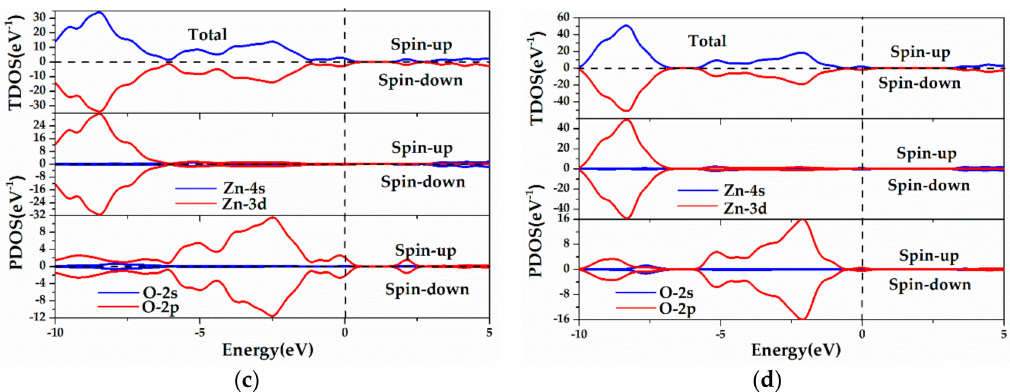
Figure 5. The calculated TDOS and PDOS (total and partial density of states) of ( a ) ZnO ML, ( b ) Y-ZnO, ( c ) V Zn -ZnO, and ( d ) V O -ZnO.